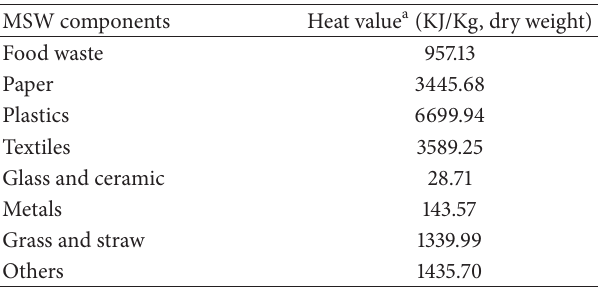
Table 5: Typical heat values of MSW components considered in this study [61].